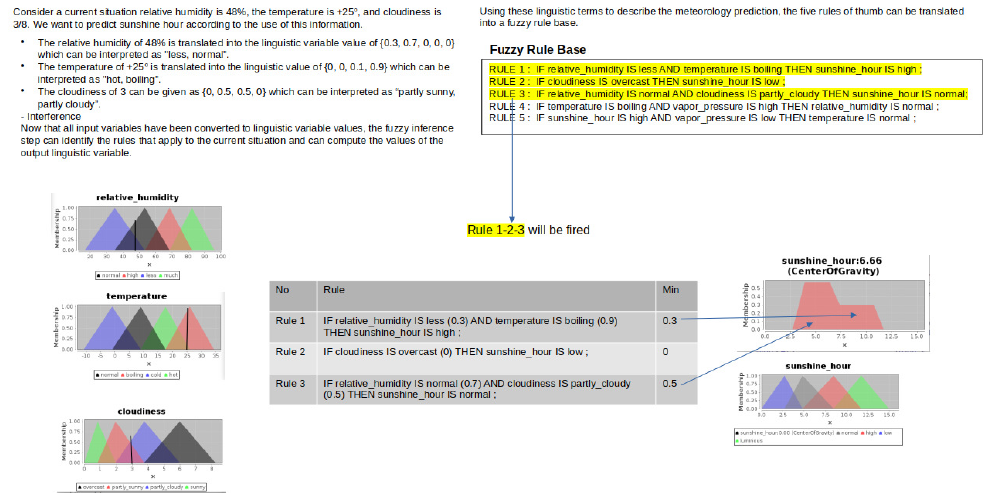
Figure 20. A sample